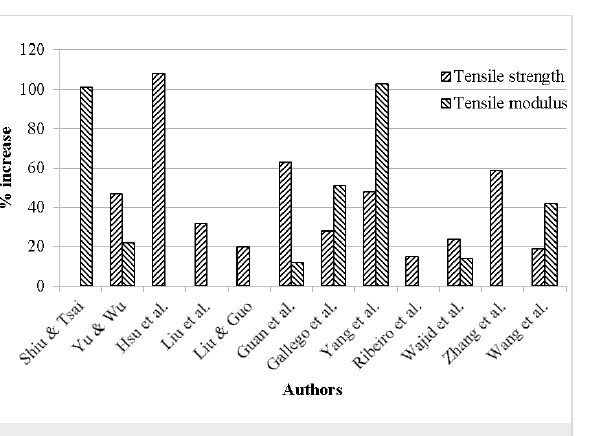
Figure 16: Increase in tensile properties of epoxy–graphene nanocom- posites [145,146,149-158].